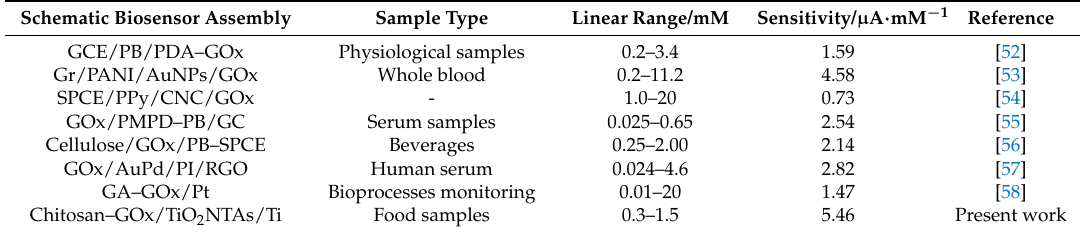
Table 2. Some examples of glucose oxidase biosensors reported in the literature. The biosensor final application, sensitivity and linear range values are